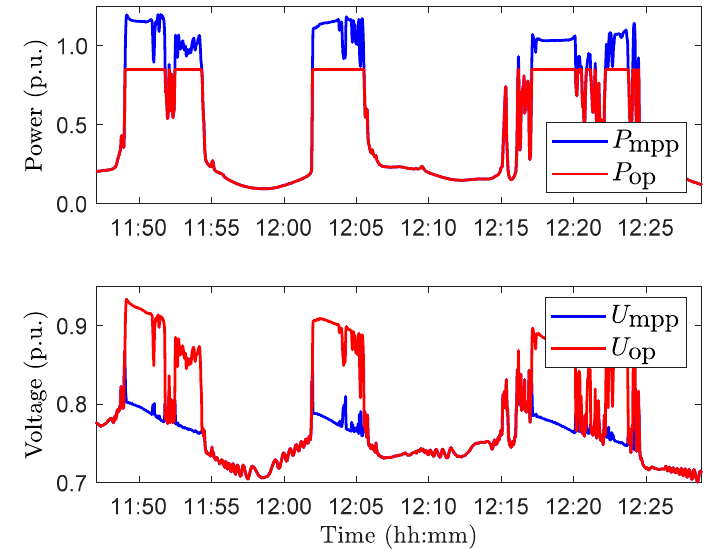
Figure 13. Operating voltage percentiles as a function of DC-to-AC power ratio.